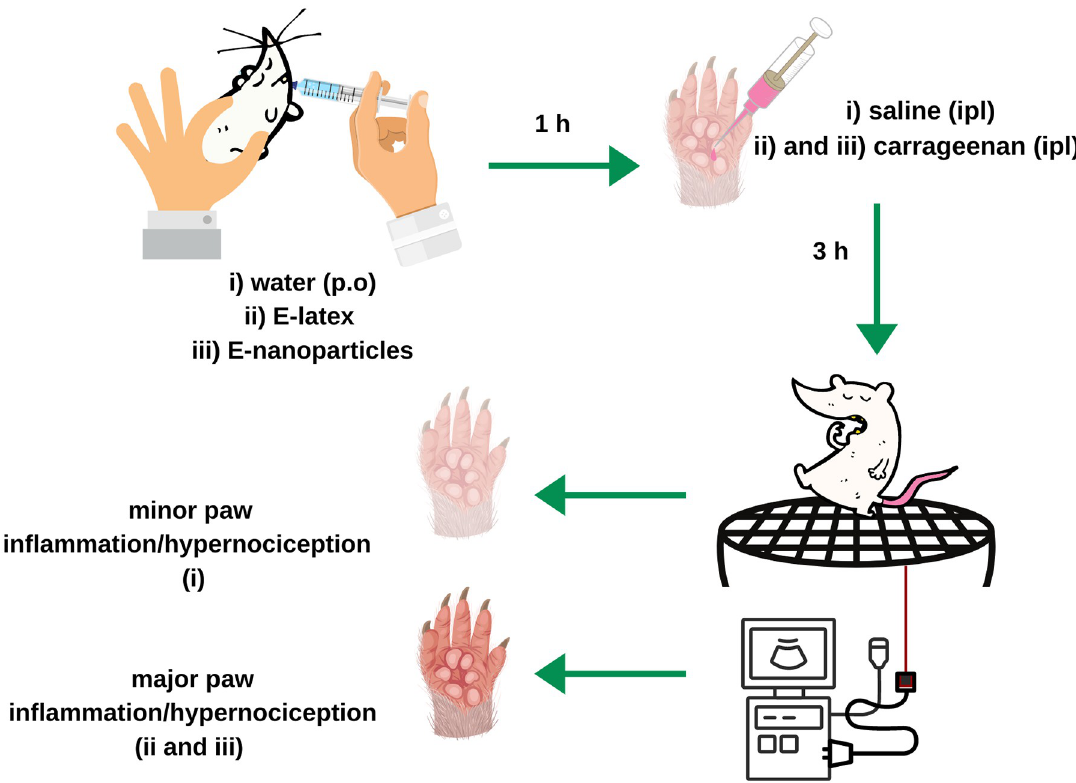
Fig 2. Illustration of the steps for in vivo hypernociception assay.